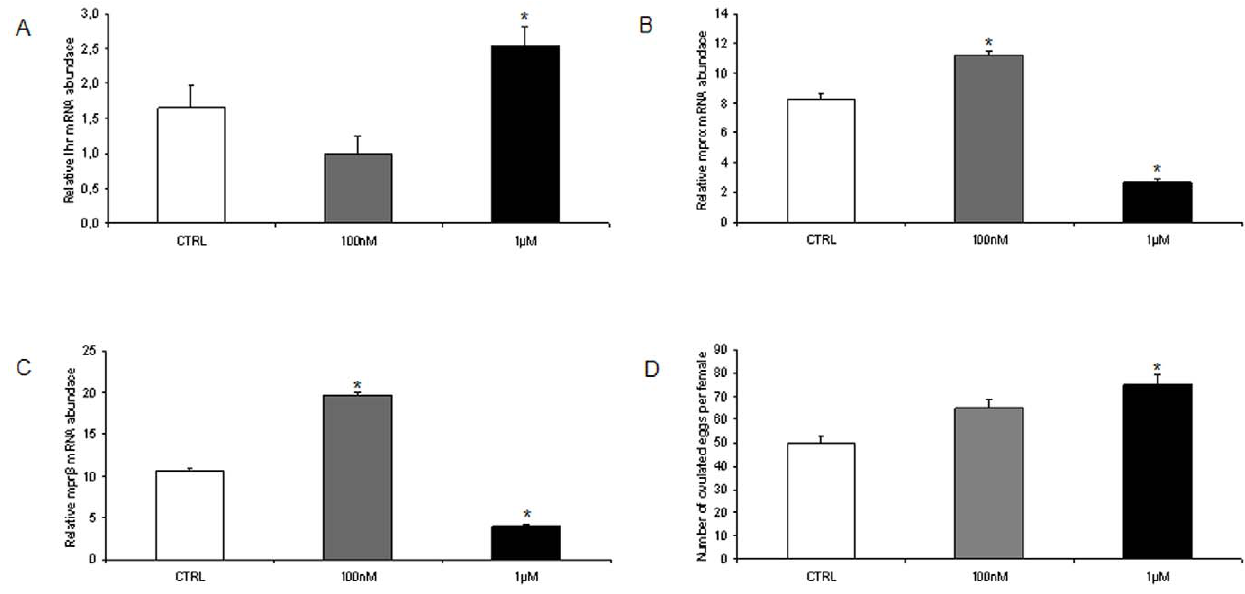
Figure 5. Invivo effects of melatonin on follicle maturation factors. (A) lhr , (B) mpr a and (C) mpr b mRNA levels, normalized against b -actin gene in fish exposed to 100 nM and 1 m M MEL. n=20 oocytes per group. Error bars indicate mean 6 S.D. (D) Number of ovulated eggs per female in fish exposed to 100 nM and 1 m M MEL. Asterisks denote exposure groups that are significantly different from the relative control group (CTRL) (p , 0.05), analyzed using ANOVA followed by Bonferroni’s multiple comparison test. doi:10.1371/journal.pone.0019978.g005 PLoS ONE |